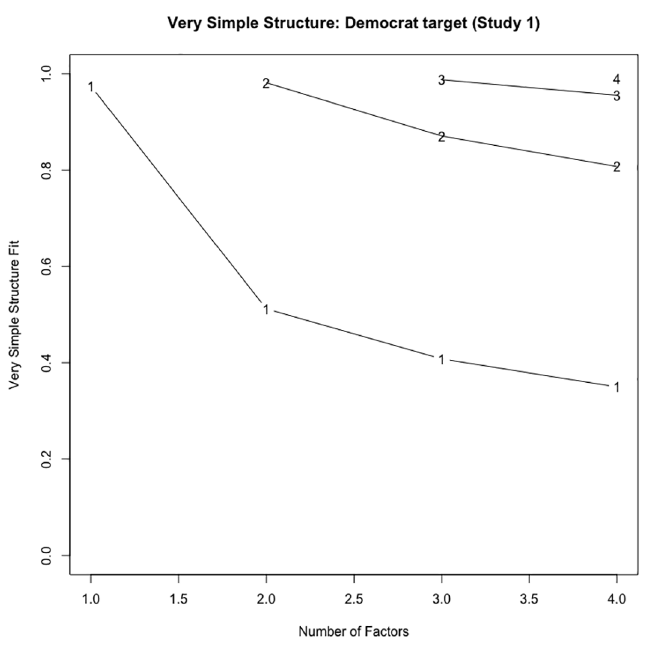
Figure A.1. Very simple structure analysis of Democrat target trait ratings in Study 1.